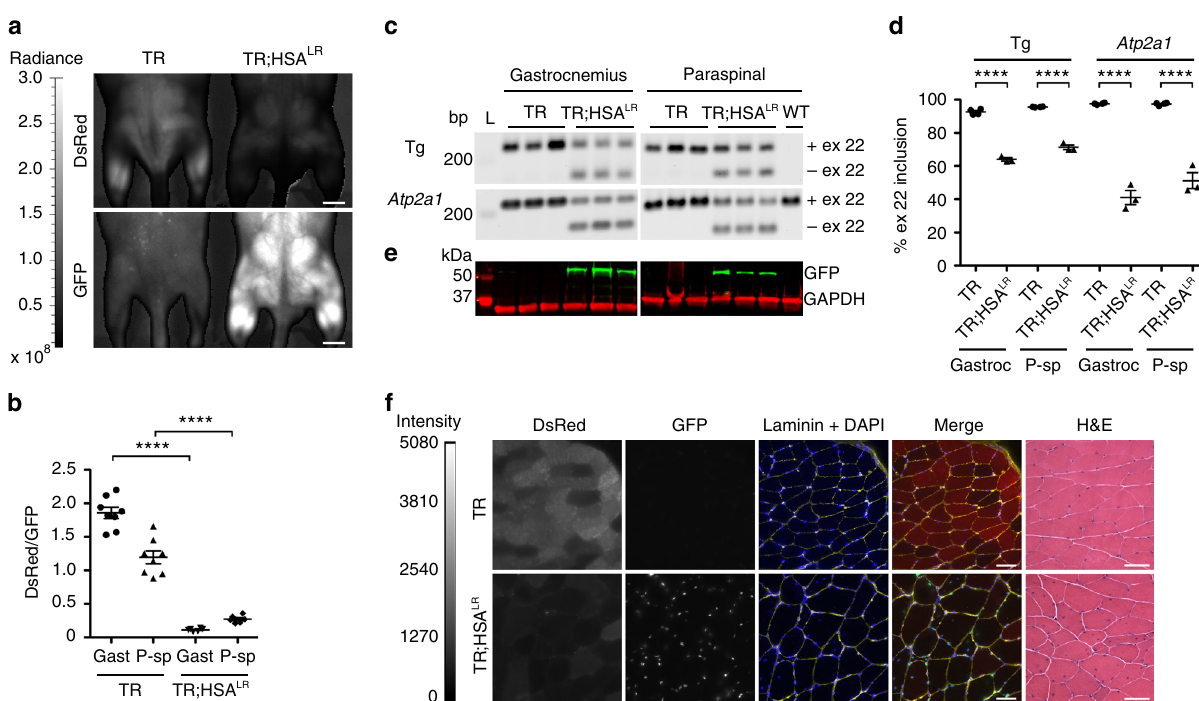
Fig. 2 TR;HSA LR bi-transgenic mice as a therapy reporter model for DM1. In the HSA LR transgenic mouse model of DM1, exclusion of Atp2a1 exon 22 is upregulated. To validate the TR- ATP2A1 splice switch as a reporter for DM1, we crossed the TR transgenic with the HSA LR transgenic model to create TR; HSA LR bi-transgenic mice. a In vivo imaging of DsRed and GFP fl uorescence in TR transgenic and TR; HSA LR bi-transgenic mice (IVIS Spectrum) under general anesthesia in the prone position. The scale shows radiant ef fi ciency (photons/second/cm2). Bars = 5 mm. b DsRed and GFP fl uorescence measured in regions of interest in bilateral gastrocnemius (Gast) and paraspinal (P-sp) muscles of TR ( N = 4) and TR;HSA LR mice ( N = 3). Error bars indicate mean ± s.e.m. **** P < 0.0001 TR vs. TR; HSA LR (one-way ANOVA). c Splicing analysis in gastrocnemius muscle by RT-PCR of the TR transgene (Tg) exon 22 (ex 22) and endogenous Atp2a1 ex 22. N = 3 each group. WT FVB wild-type. d Quantitation of splicing results in c , displayed as the percentage of exon 22 inclusion. Error bars indicate mean ± s.e.m. **** P < 0.0001 (two-way ANOVA). e Western blot of GFP protein expression in gastrocnemius and paraspinal muscles of TR and TR;HSA LR mice ( N = 3 each group), with GAPDH as loading control. kD kilodaltons. f Representative DsRed and GFP expression in TR (upper row) and TR;HSA LR (lower row) gastrocnemius muscle cryosections. Fluorescence images are the extended focus of deconvolved Z-series. Fluorescence intensity range = 0 – 5080 grayscale units. Laminin (yellow) and DAPI (blue) highlight muscle fi bers and nuclei, respectively. Merge DsRed (red) + GFP (green) + laminin + DAPI, H&E hemotoxylin and eosin. Bars = 50 μ